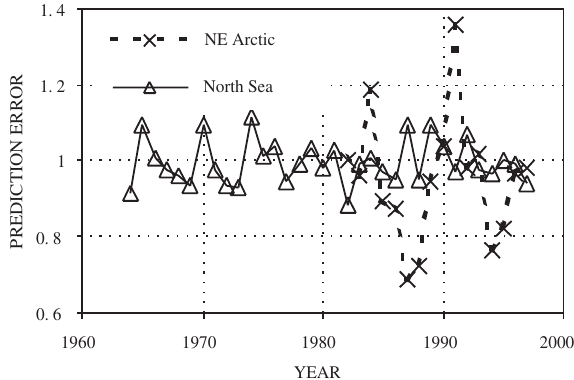
F IG . 5. – Contribution of interannual variability in growth to the error in predicting stock biomass 1-year-ahead (predicted/actual) for North Sea and NE Arctic cod. The error is due to the assump- tion that weight-at-age remains unchanged from the most recent value at the time of the